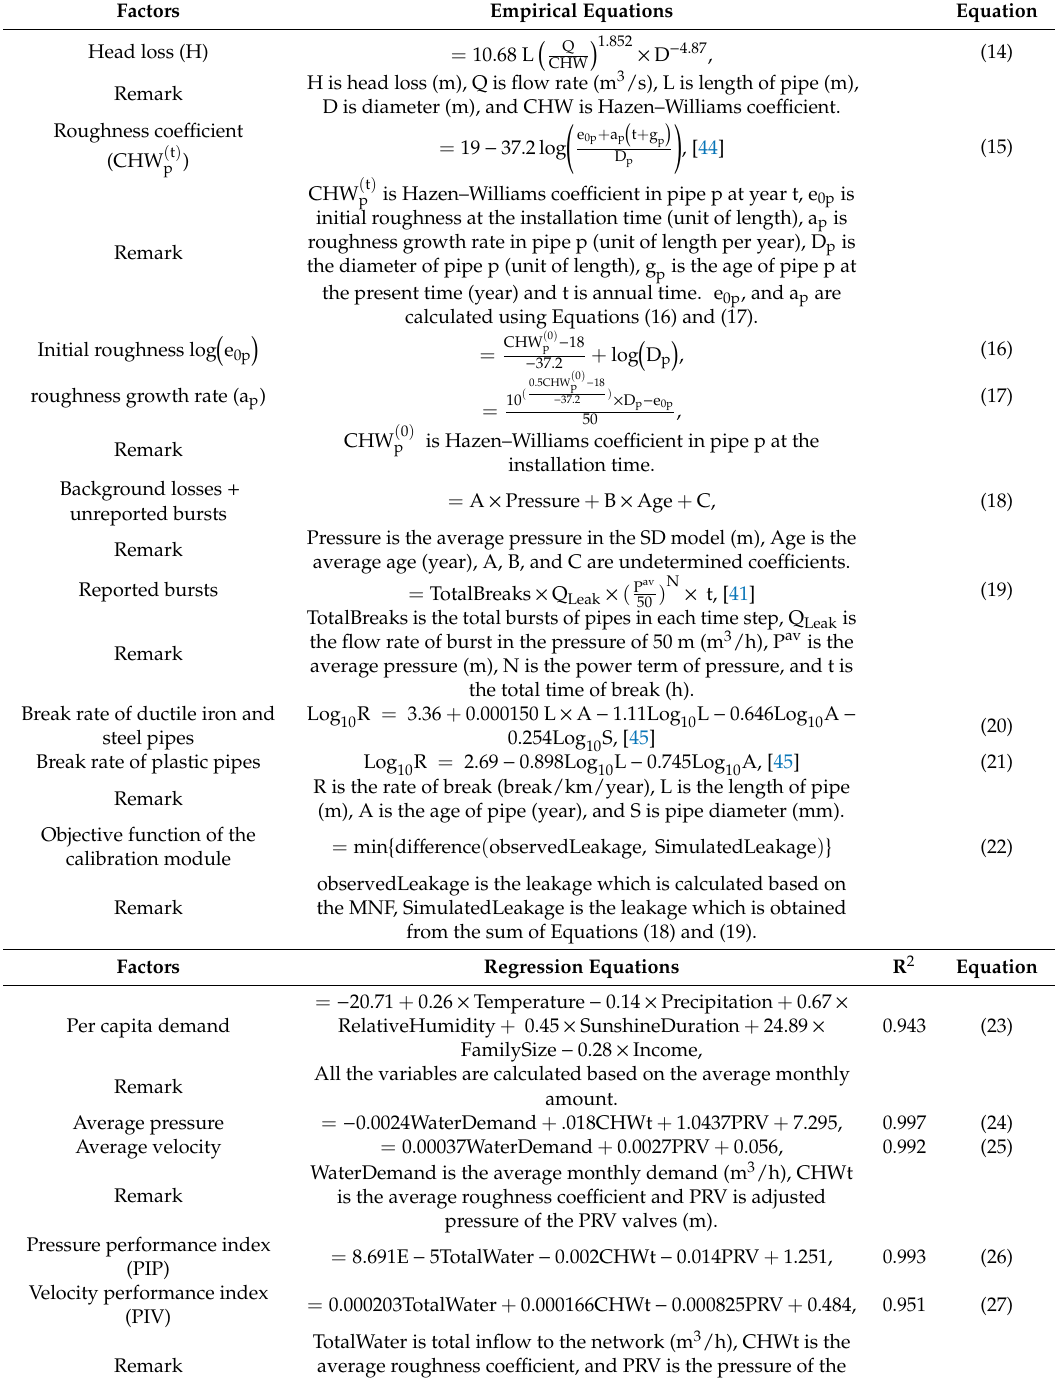
Table 1. Some of the regression and empirical equations considered in the SD